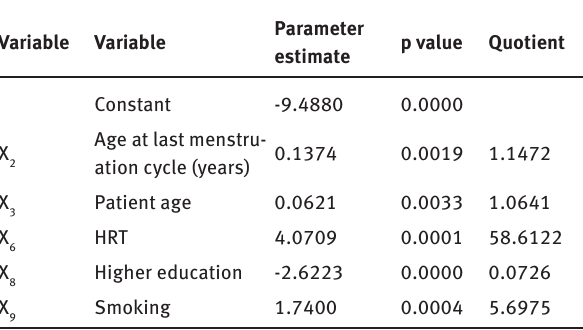
Table 11: Evaluation of parameters of the logit